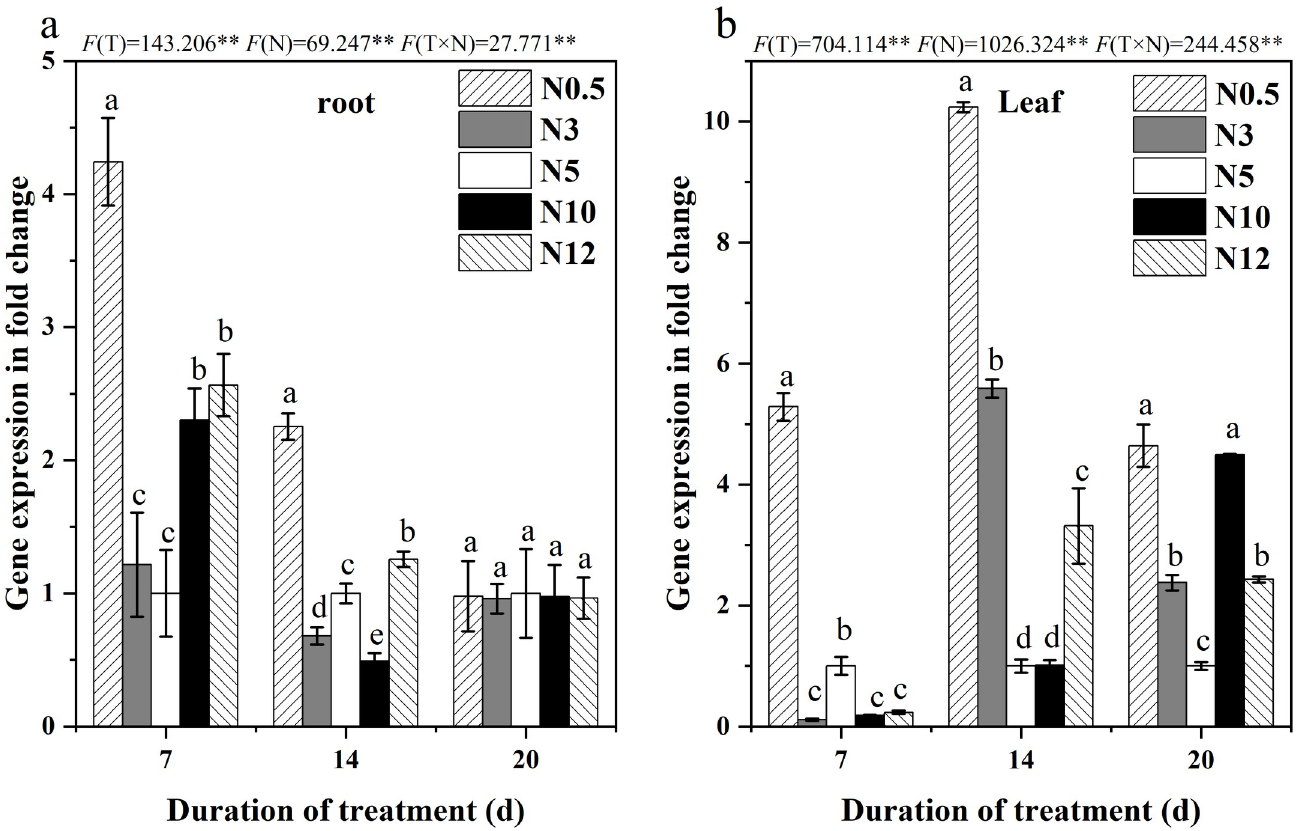
Fig 5. The relative expression pattern of BvAMT1 . 2 in sugar beet roots (a) and leaves (b) under different nitrogen treatments by qRT-PCR.